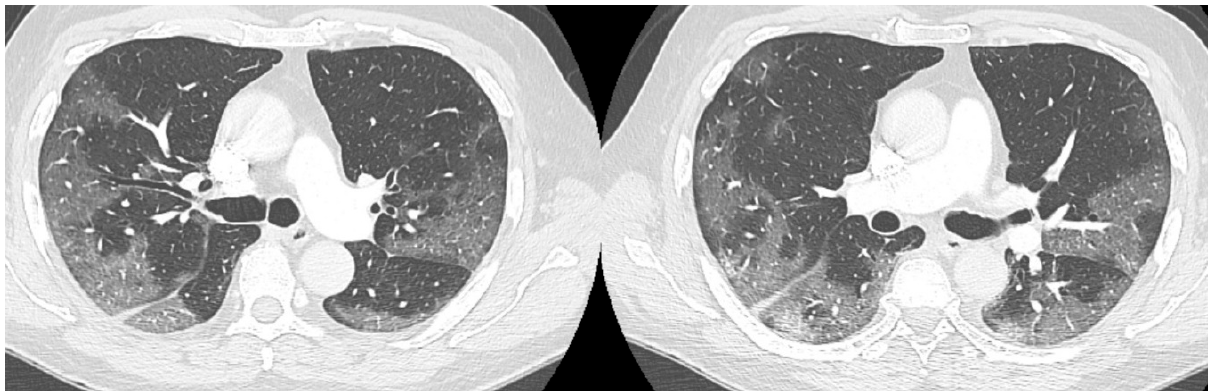
Figure 1. HRTC performed on admission with large consolidations and bilateral ground glass opacities (GGO) TSS 11/20.